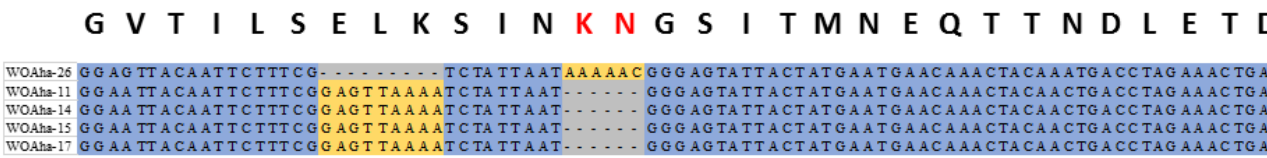
Figure 4. Bases deletions of the orf7 gene ( A ) WOAha-33 deletion “TAAAAG” resulting in WOAha-7 and WOAha-8, and ( B ) Bases deletions among WOAha-26, WOAha-11, WOAha-14, WOAha-15, and WOAha-17.